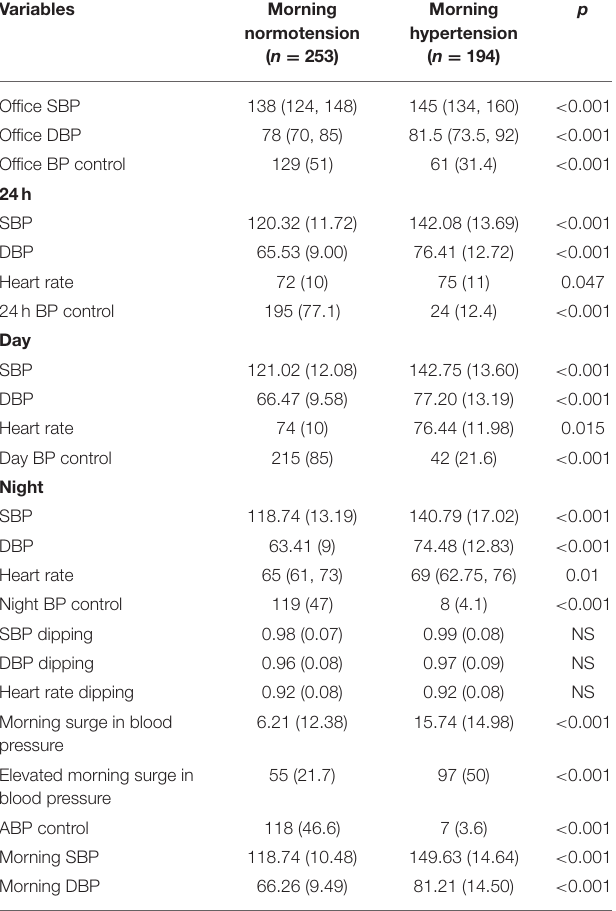
TABLE 2 | The blood pressure characteristics from ABPM between morning hypertension and morning normotension groups. Variables